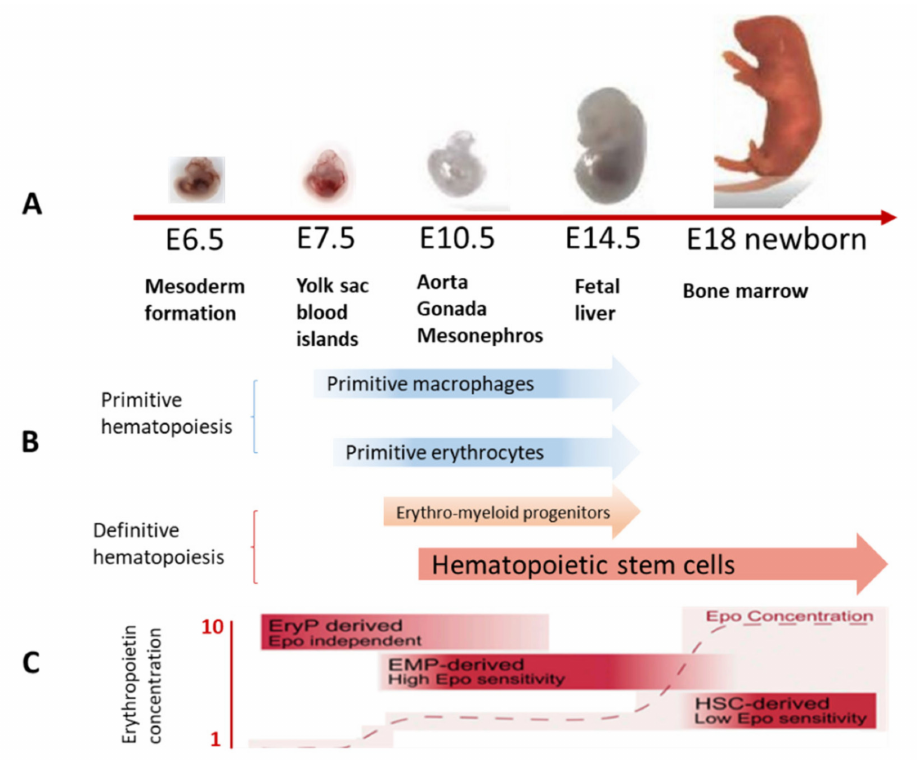
Figure 1. Hematopoiesis in the embryo. ( A ) Sequential change of sites of hematopoiesis in the embryo. ( B ) Timing of primitive and definitive hematopoiesis. ( C ) Megaloblastic erythroid precursors and fetal erythropoietin levels. Adapted from